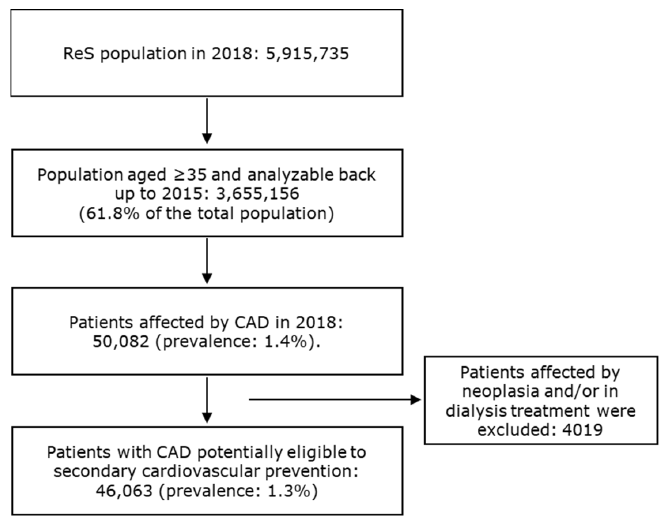
Figure 1. The flowchart describes the selection of patients affected by CAD and eligible for secondary cardiovascular prevention. Table 1. Characterization of the cohort of patients affected by CAD and eligible for long-term secondary prevention treatments in 2018 among ReS population aged ≥ 35, in terms of demographics at the index date and of comorbidities in the available previous period. Demographics and Clinical Characteristics